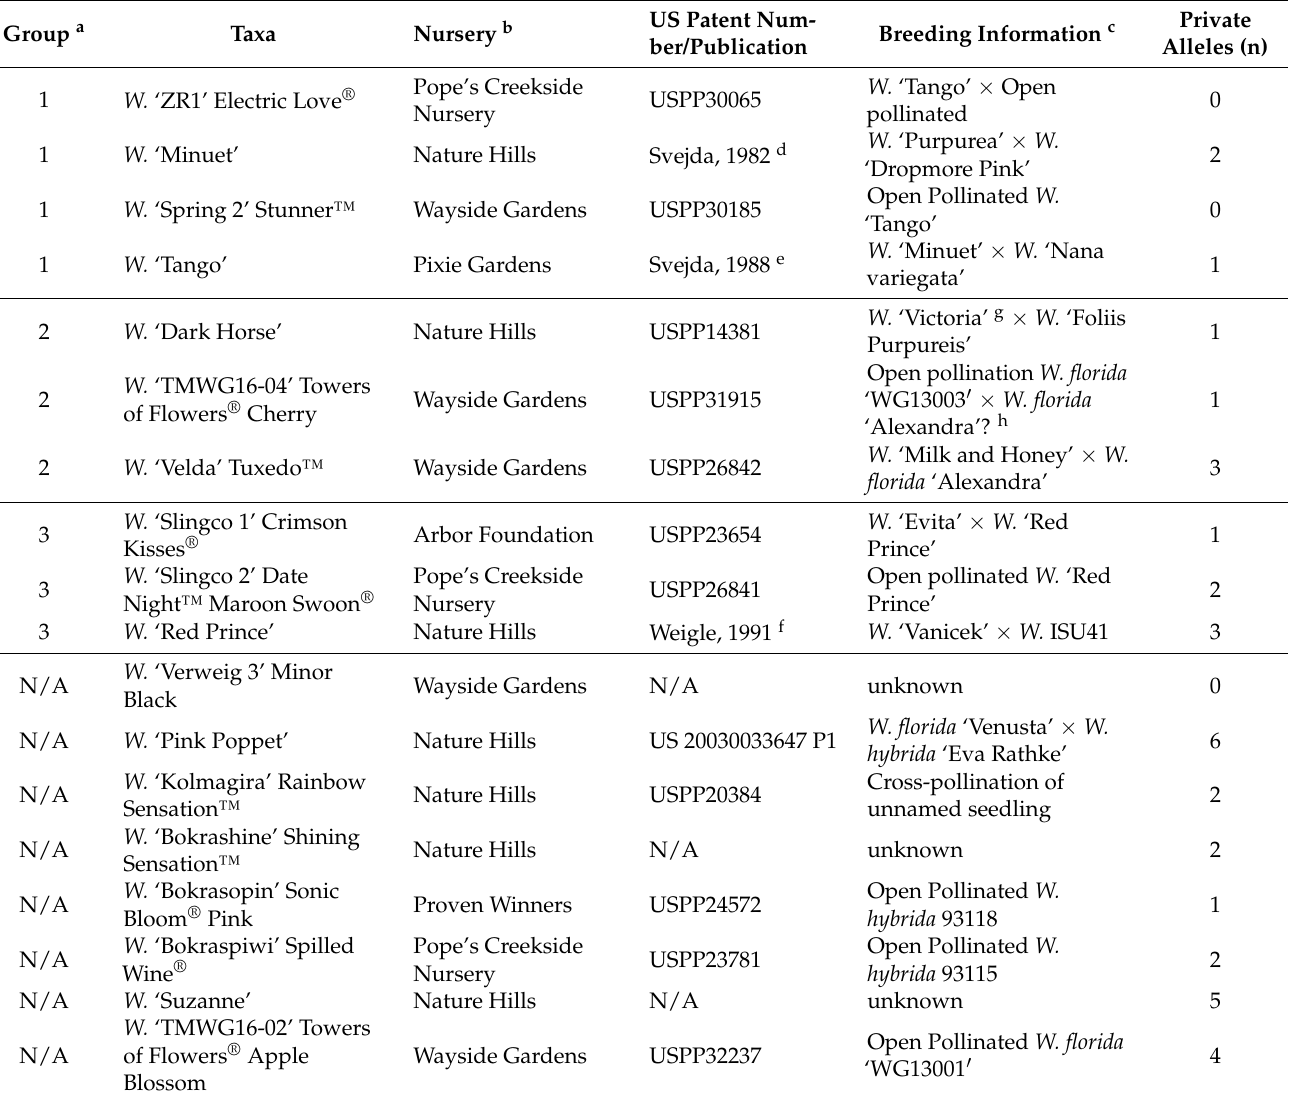
Table 2. Weigela cultivars used in this study, including breeding information and private alleles detected with 20 genomic SSRs